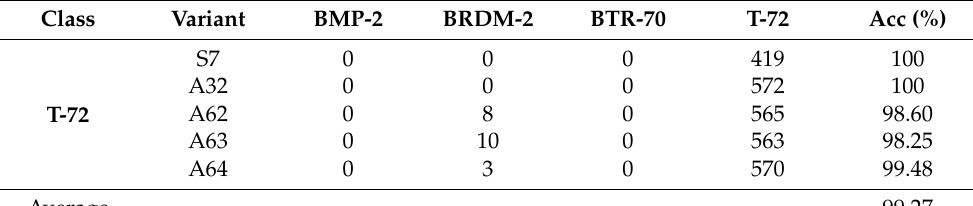
Table 8. The confusion matrix under EOC2 (configuration variant) based on the proposed method.